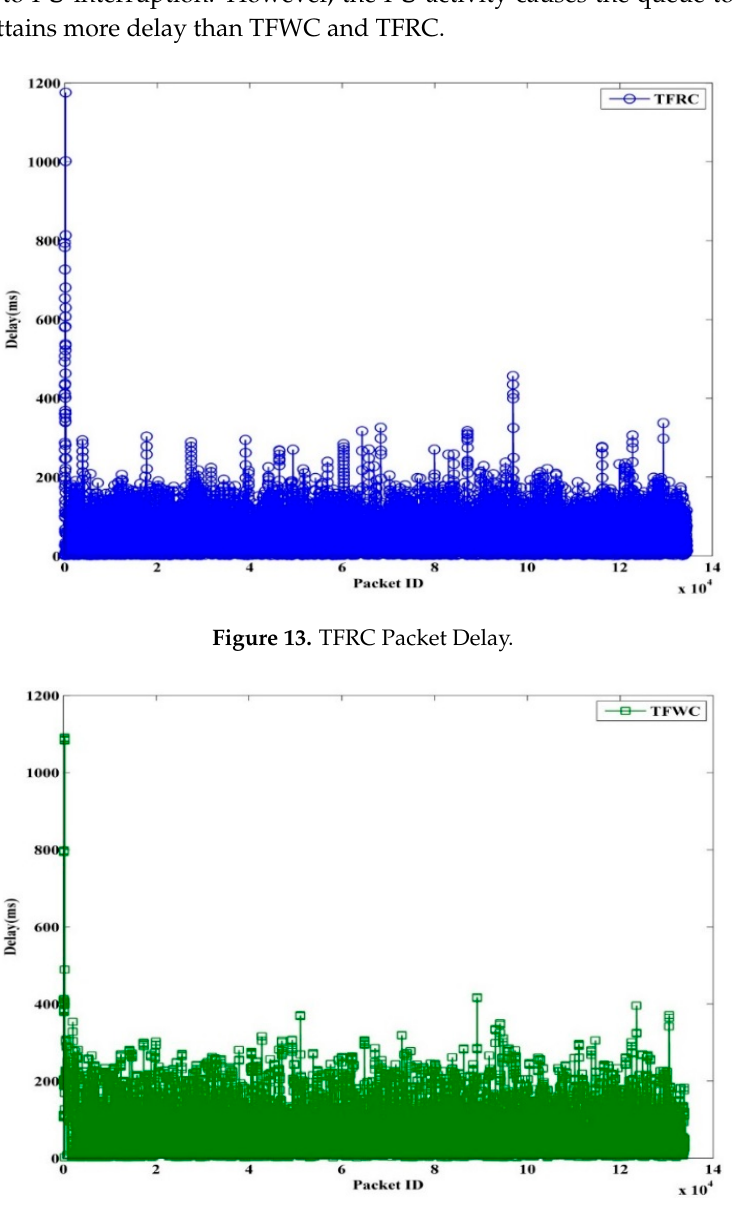
Figure 14. TFWC Packet Delay.